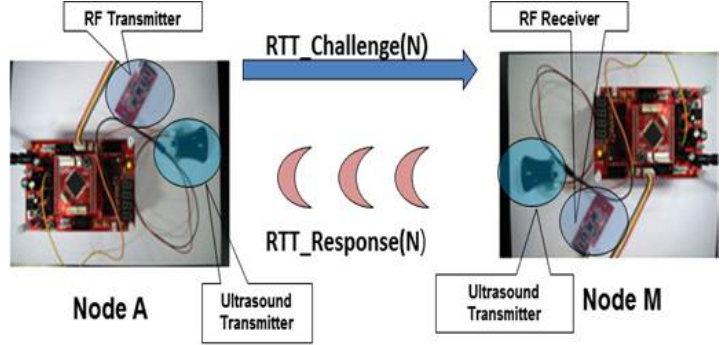
Figure 10. Experiment setup with Atmega128, RF and ultrasound modules.